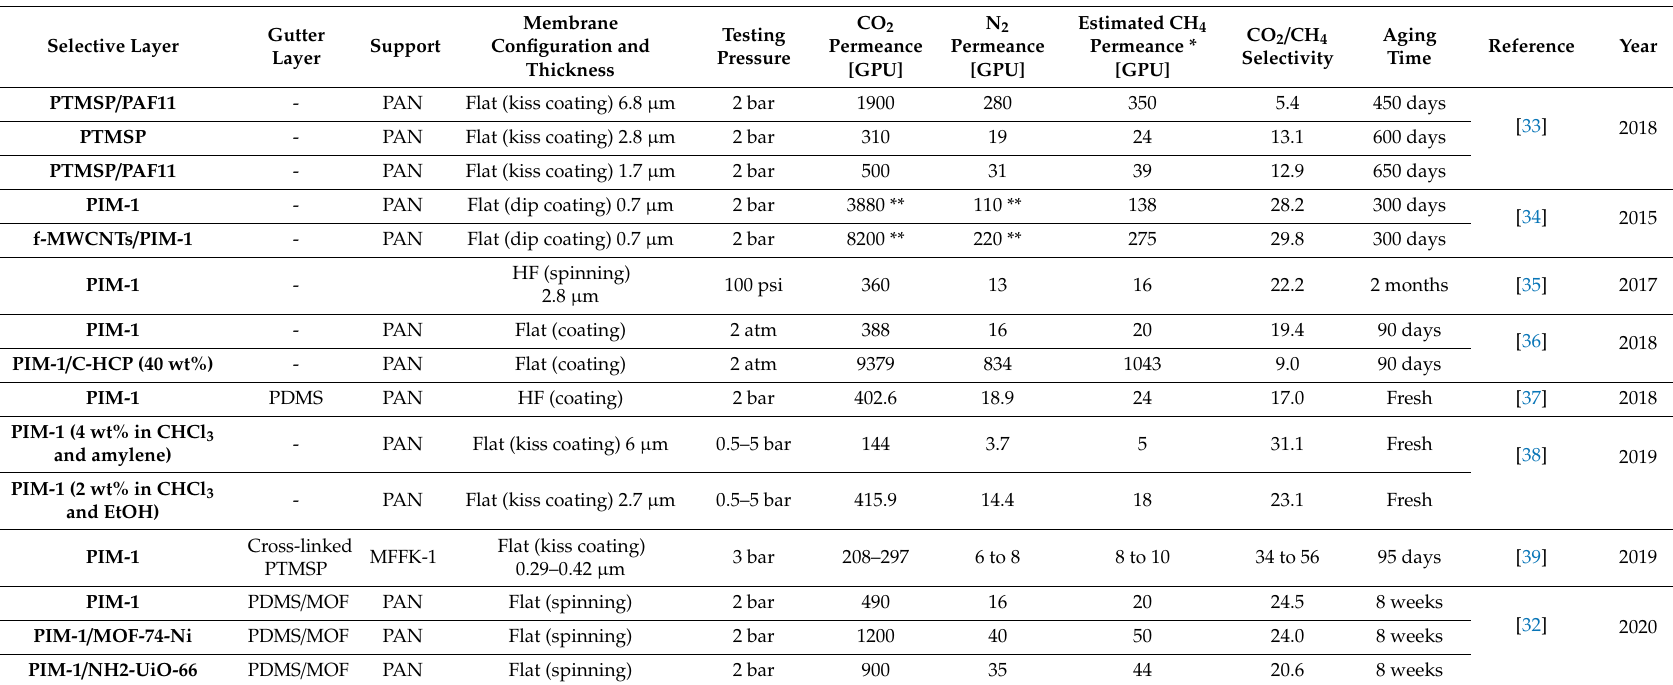
Table 1. Summary of the recent performance of thin superglassy polymers. All the membranes were tested with pure gas.